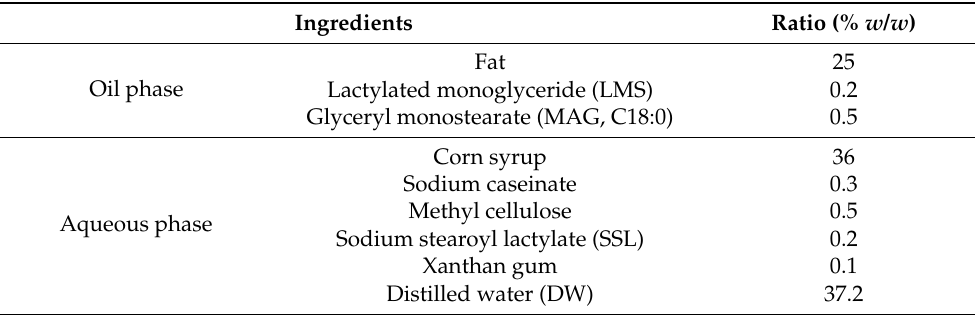
Table 5. Ingredients and their weight ratio (%) of the O/W emulsions for the preparation of whipping cream. Ingredients Ratio (% w / w